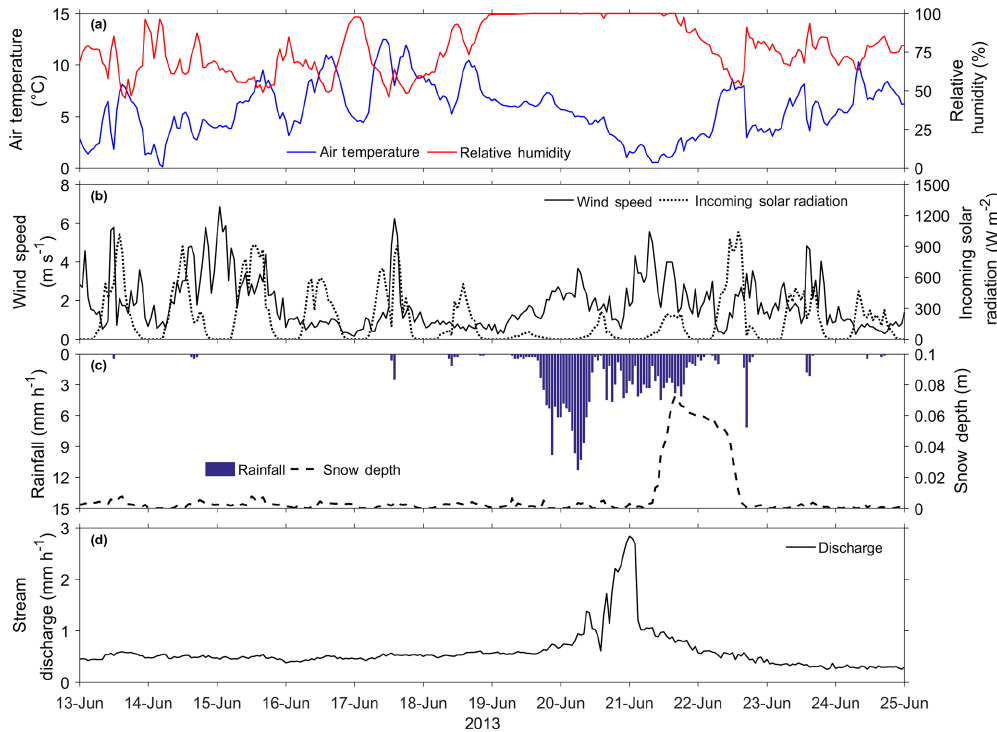
Figure 11. Example of hourly-averaged observations during 13–25 June 2013 from the Fisera Ridge station at the Marmot Creek Research Basin showing (a) air temperature and relative humidity, (b) wind speed and incoming solar radiation, (c) rainfall and snow depth, and (d) stream discharge from Upper Marmot